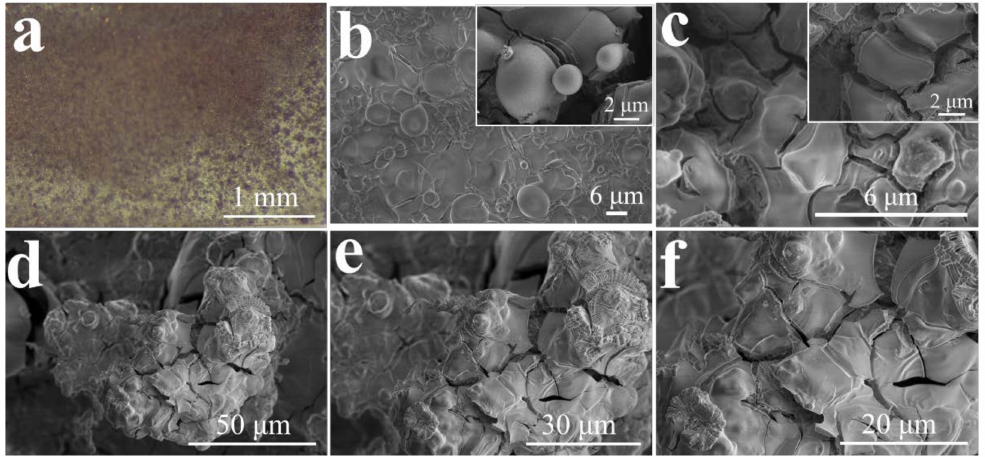
Figure 2. ( a ) Photograph of the Cu foil substrate after 2.5 h of Al electrodeposition at –1.70 V and 70 ◦ C. SEM images or with enlarged details (inset) of the Al layer electrodeposited at –1.70 V ( b ), –1.85 V ( c ) at 70 ◦ C or –1.85 V at 90 ◦ C ( d – f